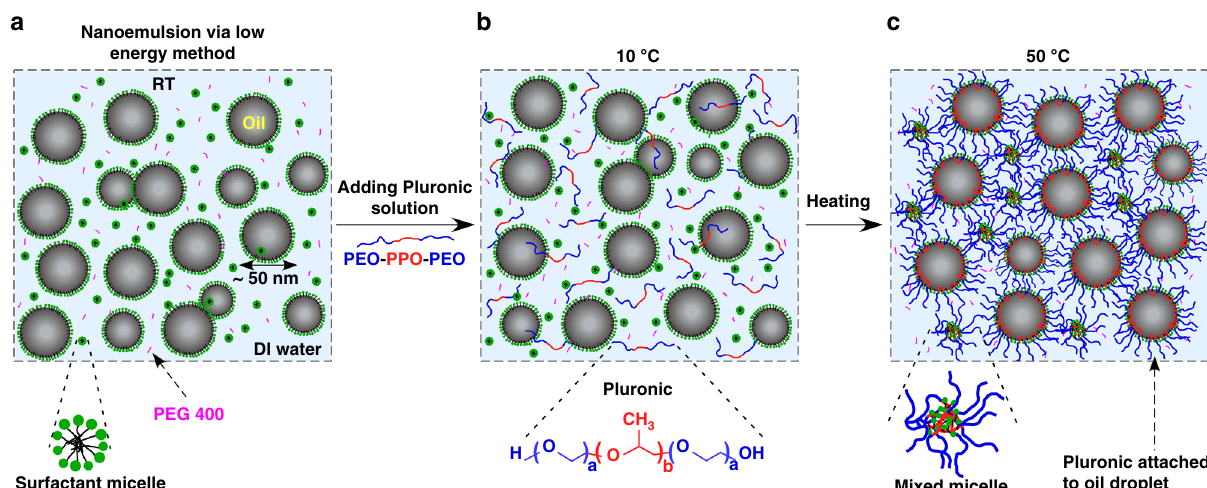
Fig. 1 Schematic diagram of the nanoemulsion system and hypothesized gelation mechanism. a Formation of the oil-in-water nanoemulsion prepared using a low energy process containing oil, surfactant (Tween 80 and Span 80, HLB = 13) and PEG 400 as a cosurfactant. b Addition of mixed Pluronic solution into the nanoemulsion suspension to impart thermoresponsive behavior. Final concentration of Pluronic is 4.7% wt. c Gel formation at 50 °C through adsorbing midblock of Pluronic onto the droplet interface and mixed micelles formation between Pluronic and excess emulsi fi ers in the aqueous solution